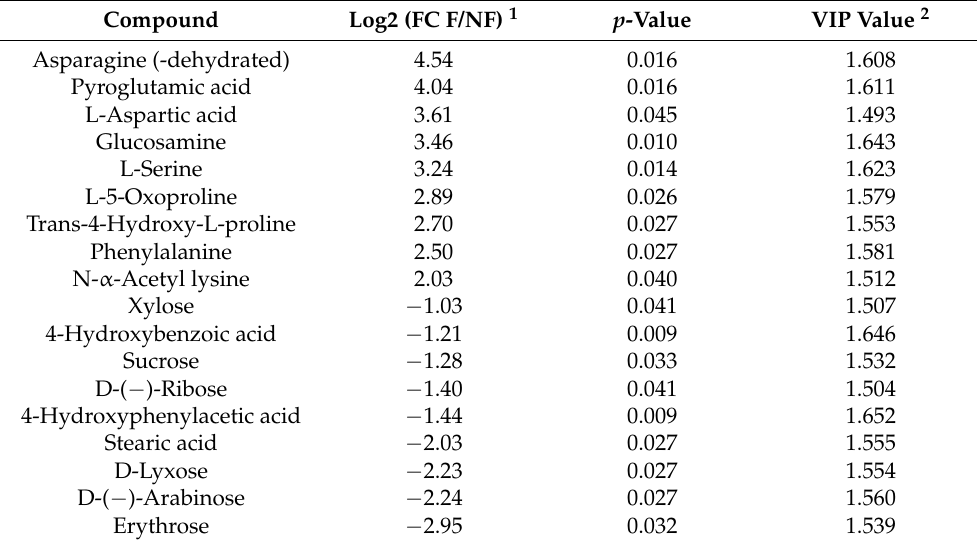
Table 1. Differential metabolites between Juniperus communis L. seeds produced by plants grown in fertilised (F) and non-fertilised (NF) conditions.